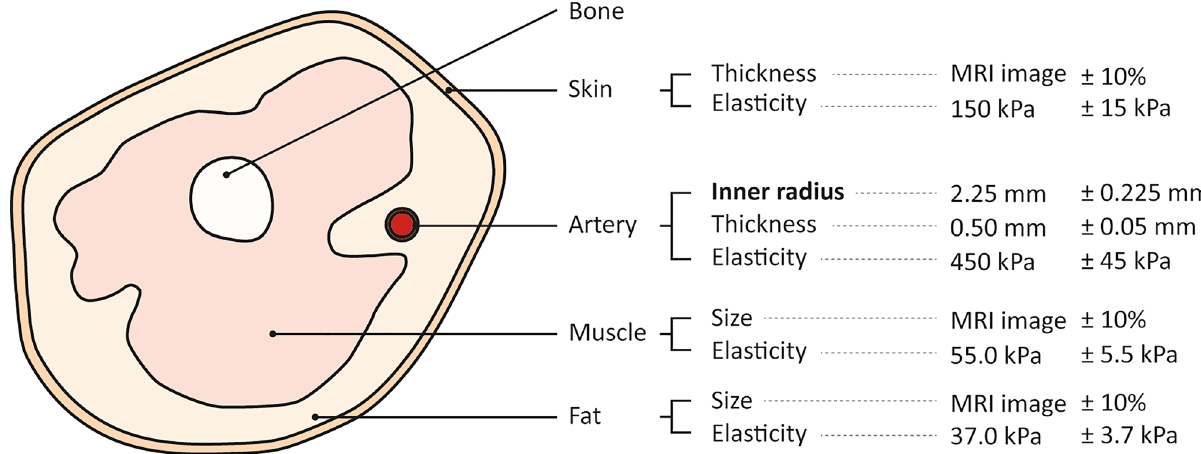
Figure 3. Upper arm parameters varied in the parametric study and experiment. Four physiological components were considered in the parametric study. Nine parameters in the four physiological components were investigated in the parametric study with the MRI-based FEM model, and among them, the inner radius of the artery (in bold) letters is varied within phantoms for the experiment. The baseline and the range of the parameters’ values used for the parametric study are